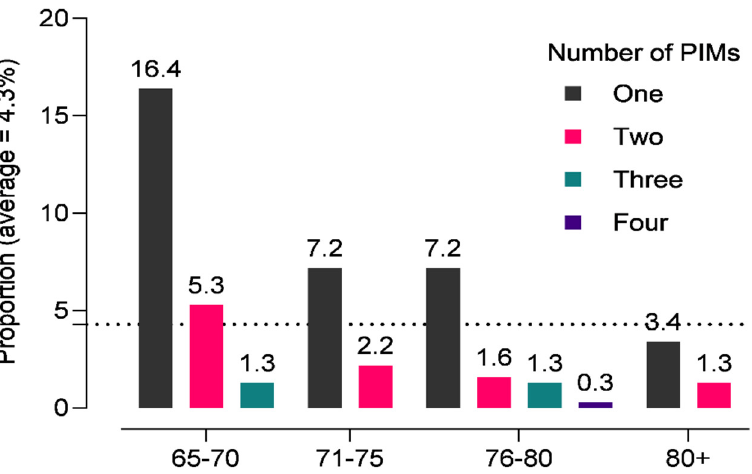
Figure 2. Proportion of older adults receiving potentially inappropriate medications according to 2019 AGS Beers criteria in an outpatient setting in Ethiopia.